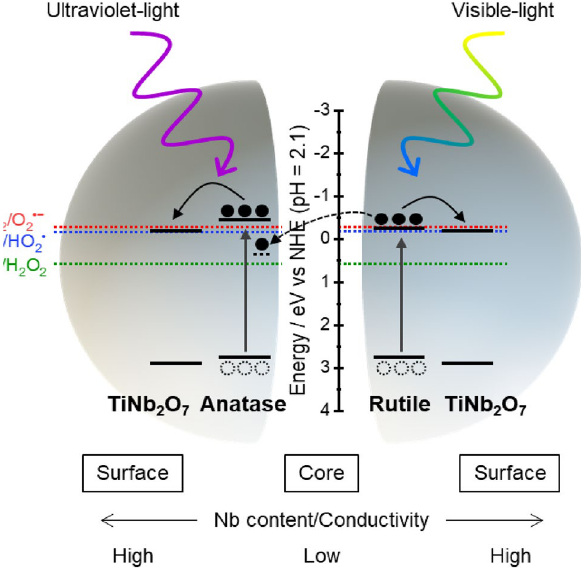
Figure 8. Schematic illustration of proposed mechanism of enhanced photocatalytic performance by Nb doped TiO 2 nanoparticles with gradient chemical compositional structure. The reported energy levels were used 45,61,64